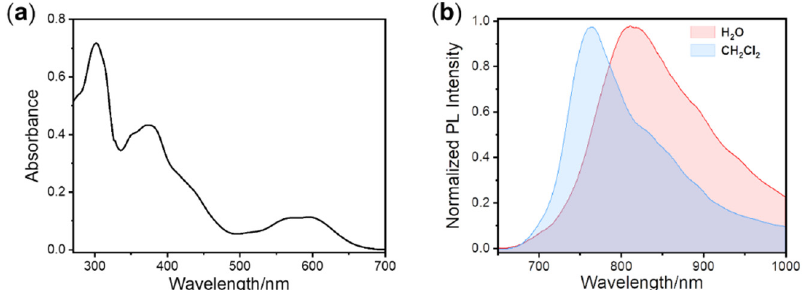
Figure 2. ( a ) UV/vis absorption spectrum of complex 4 ; ( b ) Emission spectra of complex 4 under 405 nm excitation. The concentration of complex 4 was 50 μ M. 405 nm excitation. The concentration of complex 4 was 50 µ